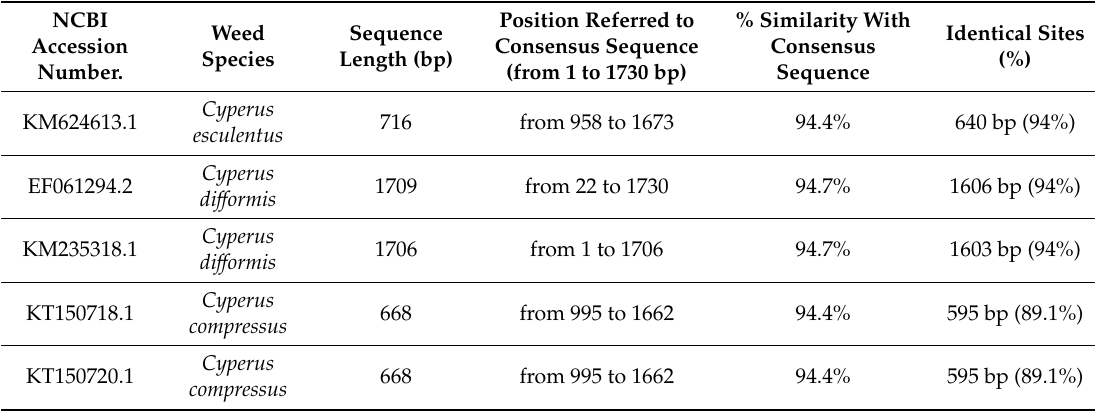
Table 1. Accession numbers of five ALS sequences used for the alignment, downloaded from NCBI website on March 2019 and the following obtaining of consensus